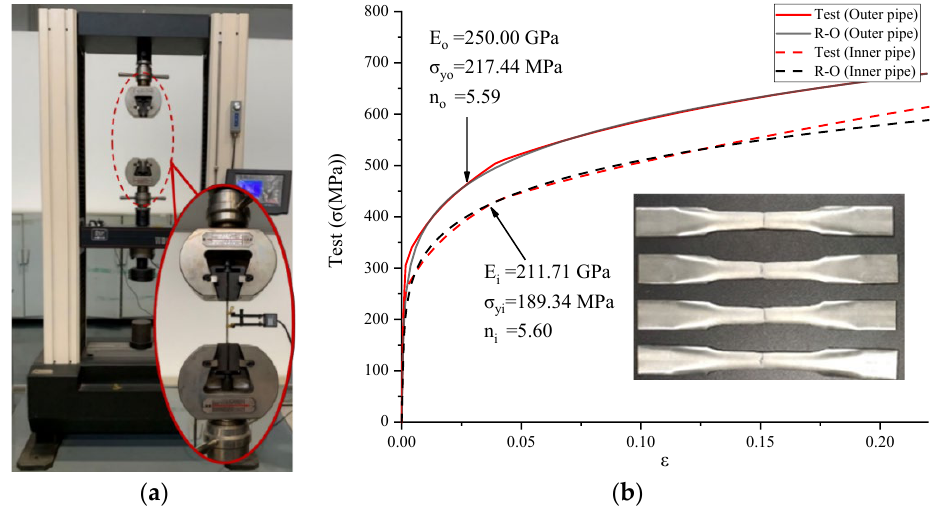
Figure 4. ( a ) The uniaxial tension test. ( b ) Engineering stress–strain curves of the test sample.